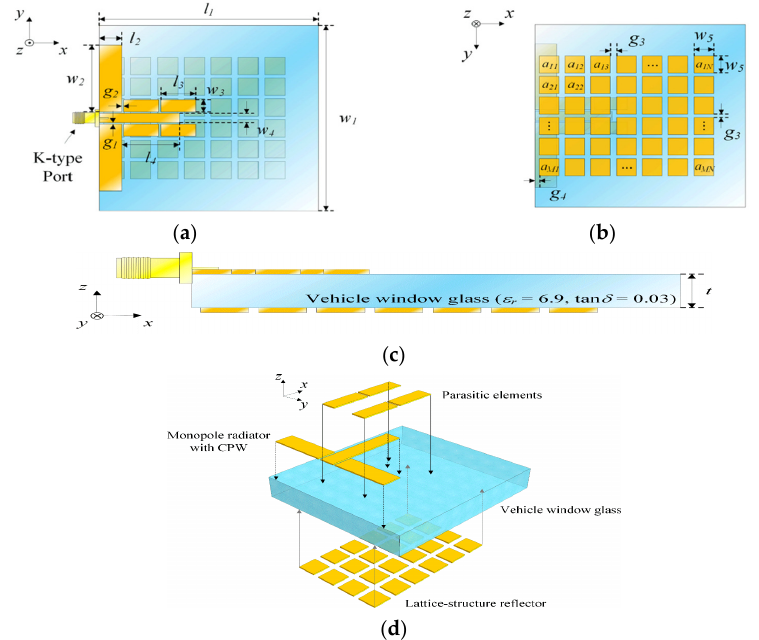
Figure 12. Geometry of the proposed printed antenna: ( a ) top view; ( b ) bottom view; ( c ) side view; ( d ) isometric view [28]. The coupling of 20 dB with uniform distribution of amplitude and a 2 dBi maximum broadside gain is achieved and a side-lobe level of − 12.1 dB is achieved. All simulated parameters well agree with the measured one.